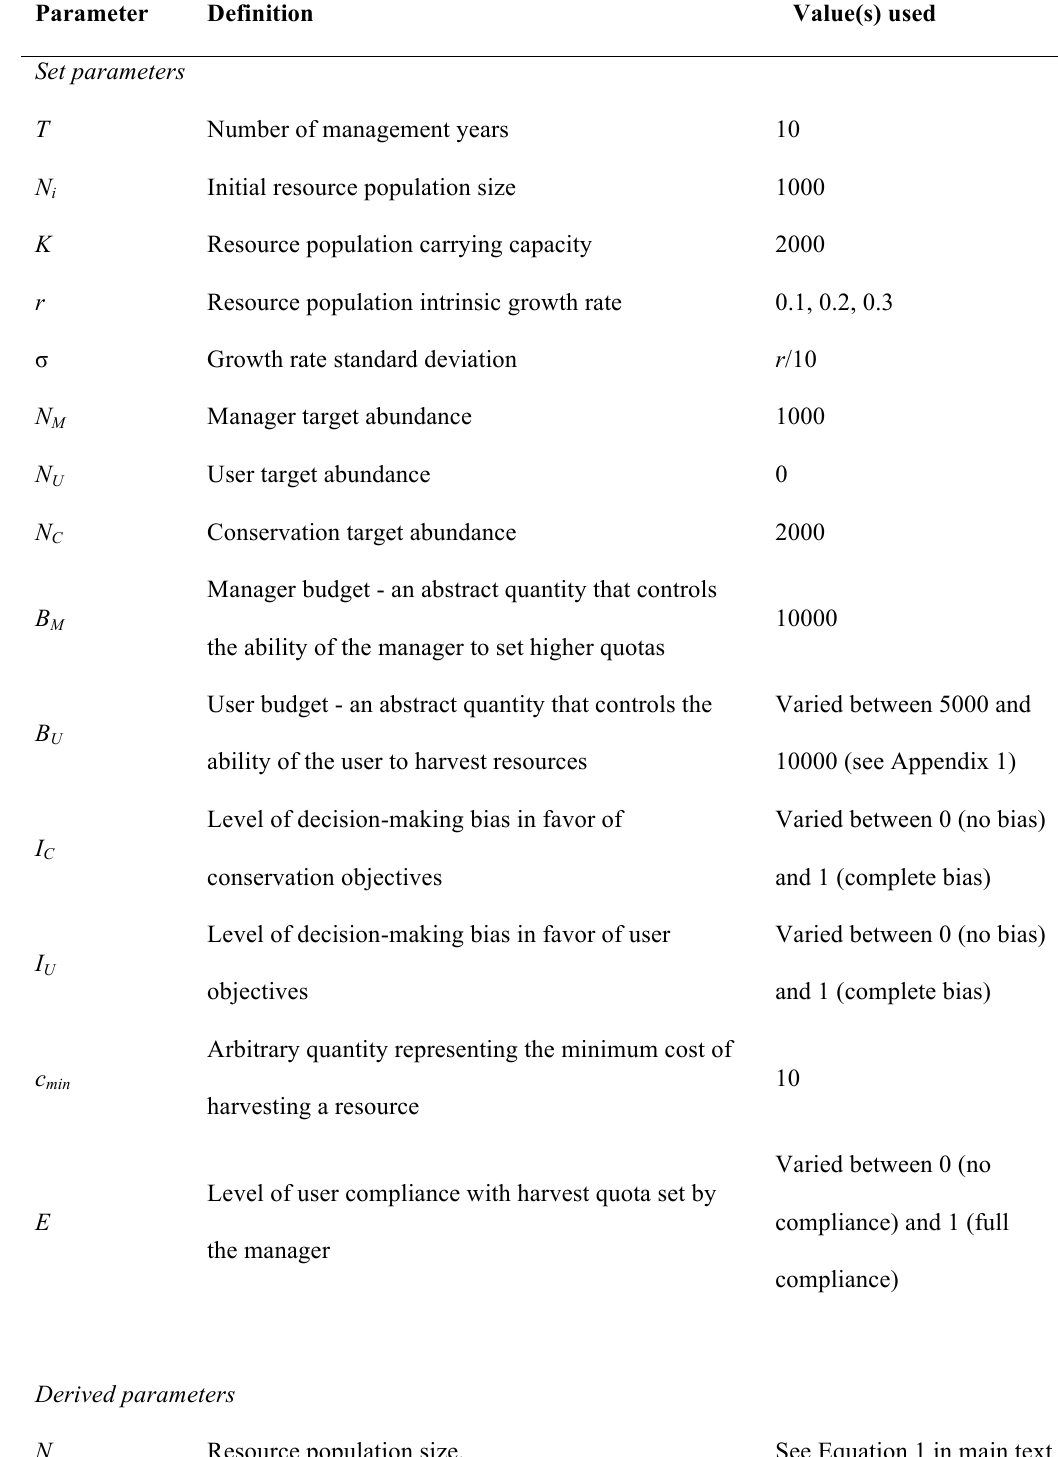
Table A3.1. Definition and value of set and derived